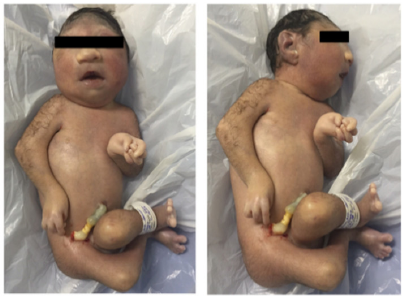
Figure 3. Newborn with 29 weeks gestational age showing microcephaly and arthrogryposis. The infantdied 5 min after birth (Case 10).